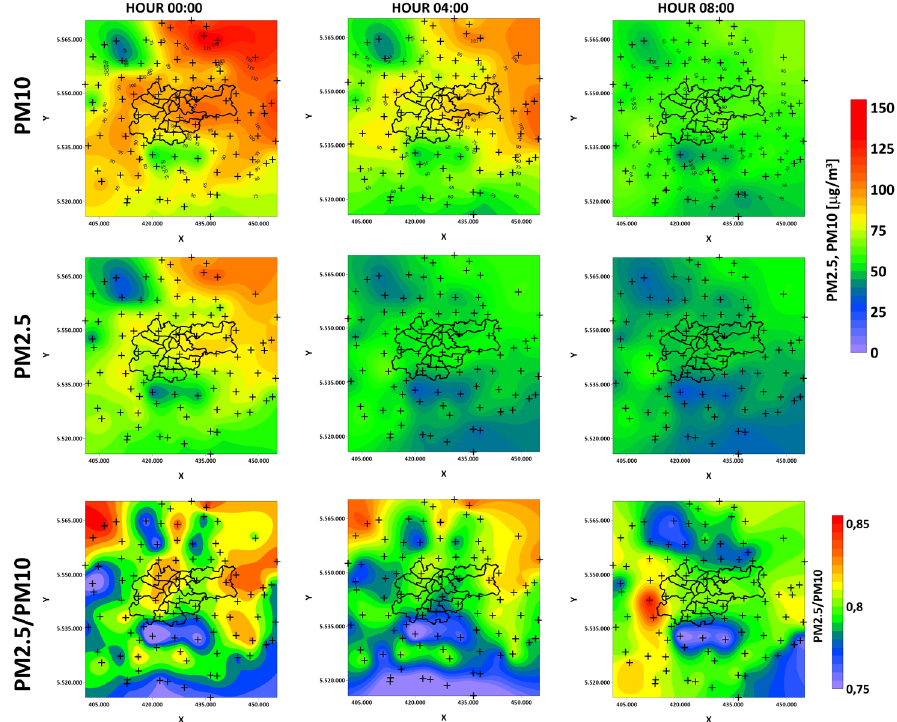
Figure 12. PM10 and PM2.5 GWR models with their ratio on the 11th of March (inflow).